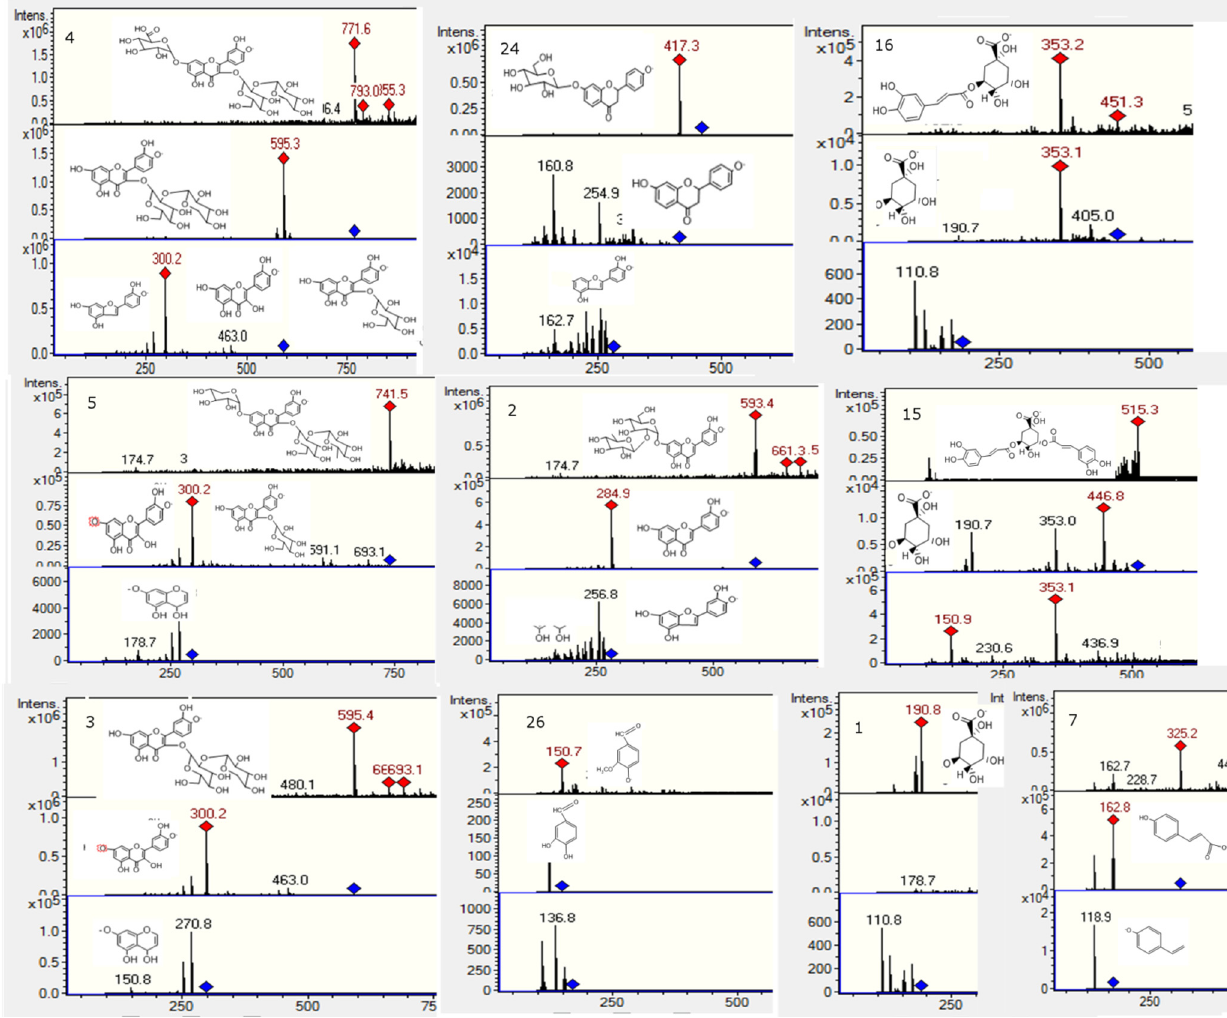
Figure 4. Structures, full scan MS and MS n spectra of Peaks 1 , 2 , 3 , 4 , 5 , 7 , 15 , 16 , 24 and 26